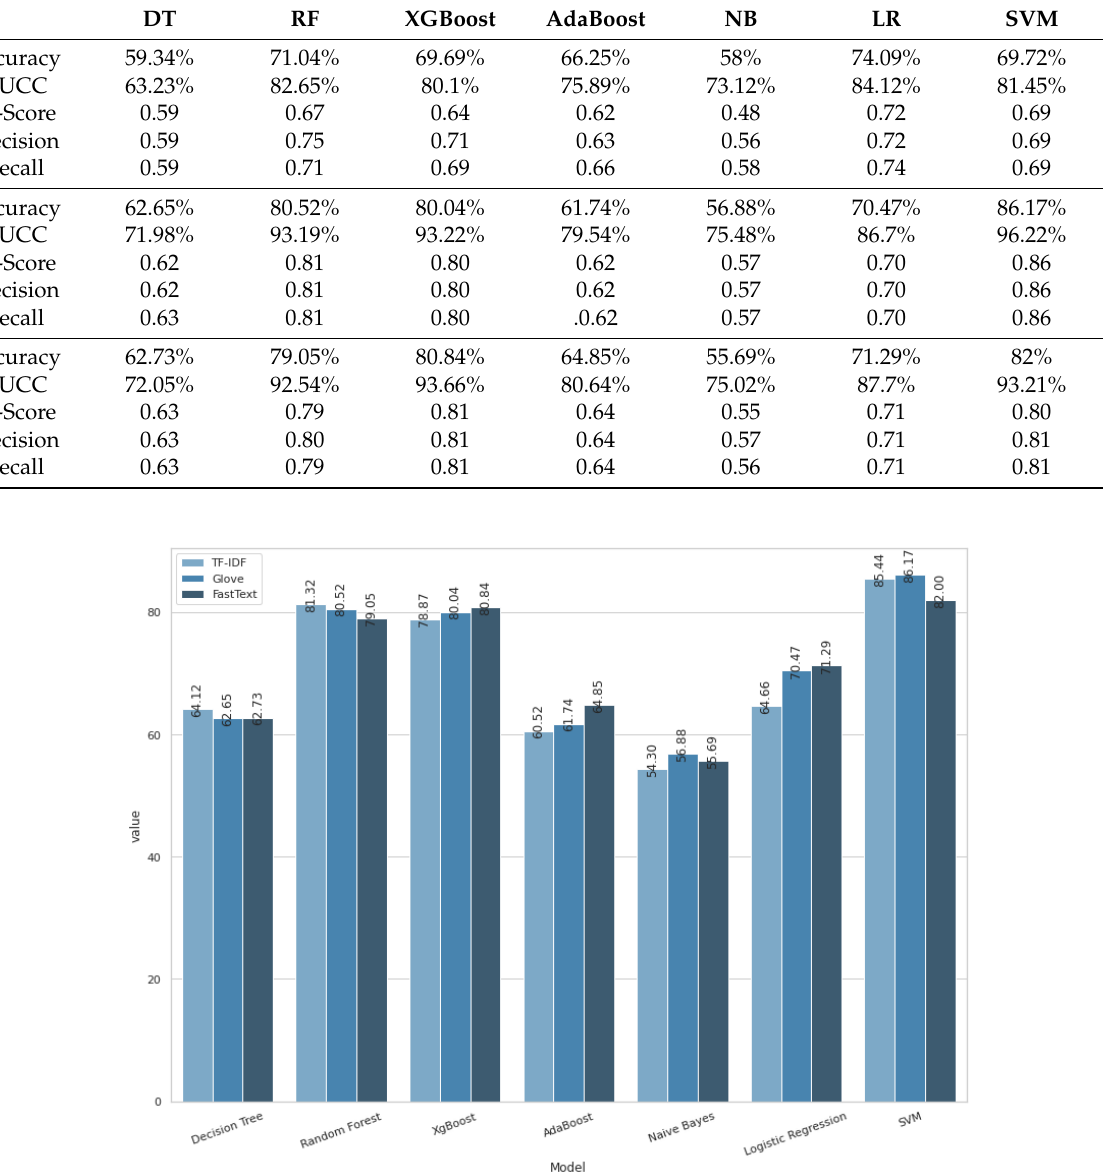
Figure 7. Visualisation of the accuracy of traditional classifiers using TF-IDF, Glove, and FastText word embedding